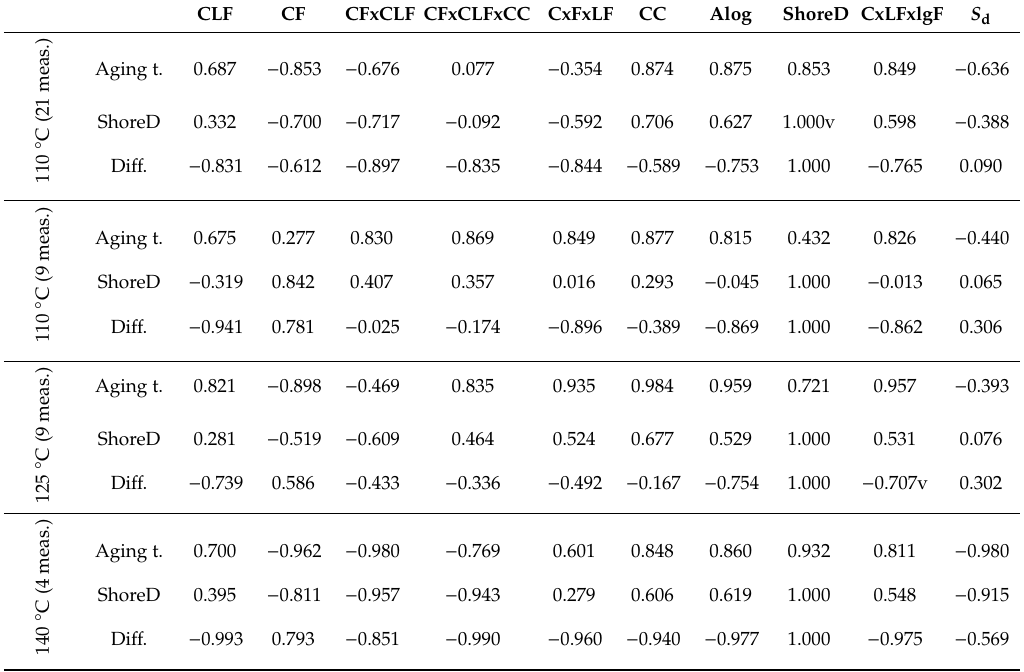
Table 2. Correlations between deducted quantities and equivalent aging time, hardness, and hardness changing of PVC cable samples.